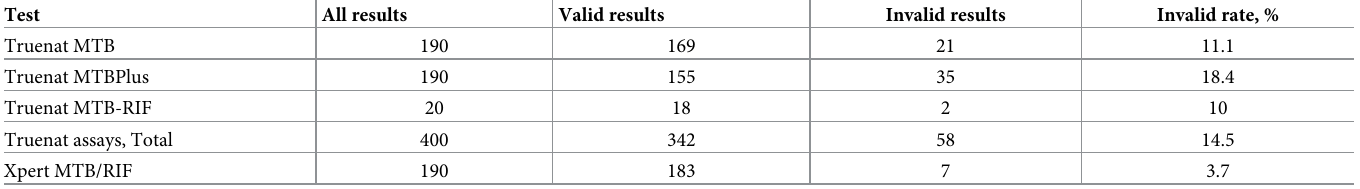
Table 2. Non-determinate results of Truenat assay and Xpert MTB/RIF in direct sputum specimen received in the reference laboratory.